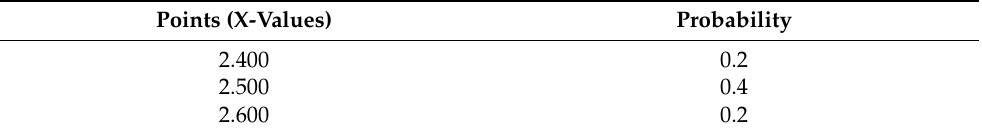
Table 7. Cumulative distribution